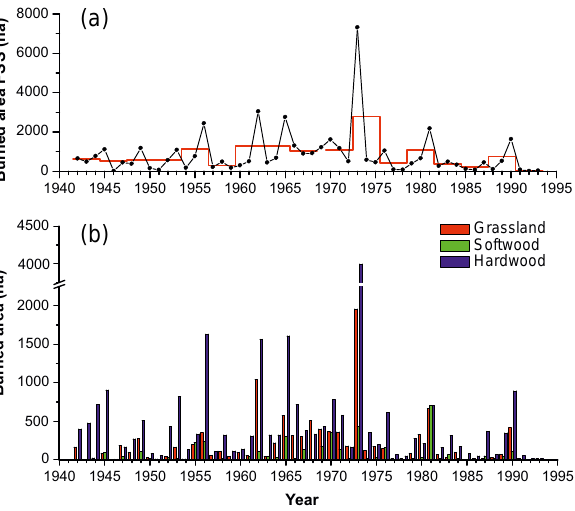
Figure 7. (a) Record of the burned area by fires in southern Switzer- land (FSS; black dots: annual averages, red line: 3-year averages), (b) annual burned area of grassland, softwood, and hardwood in southern Switzerland from 1942 to